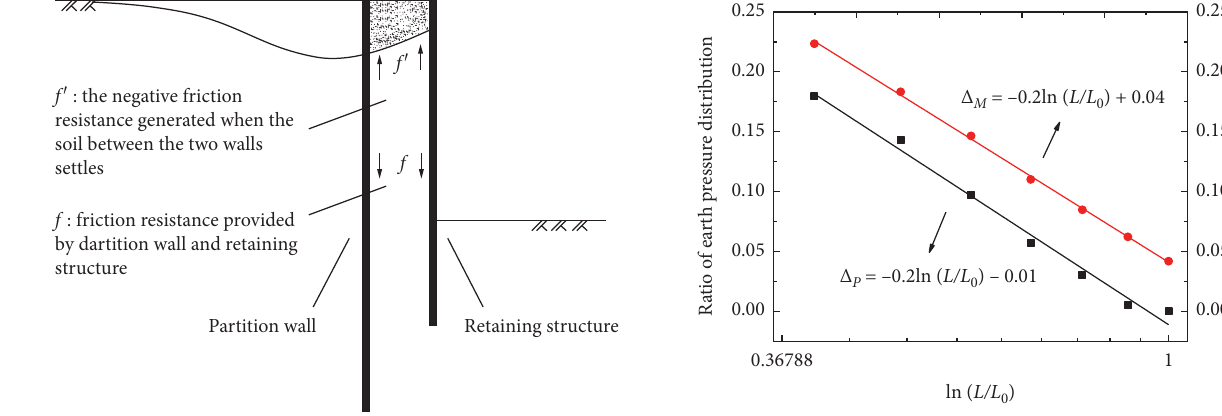
− ln ( L / L ) and Δ − ln ( L / L ) M P 0 0